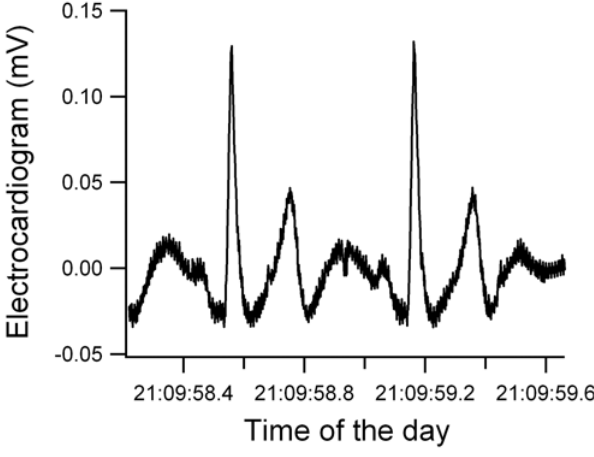
Figure 1. An excerpt of the electrocardiogram signal of Nugget showing the PQRT peaks.